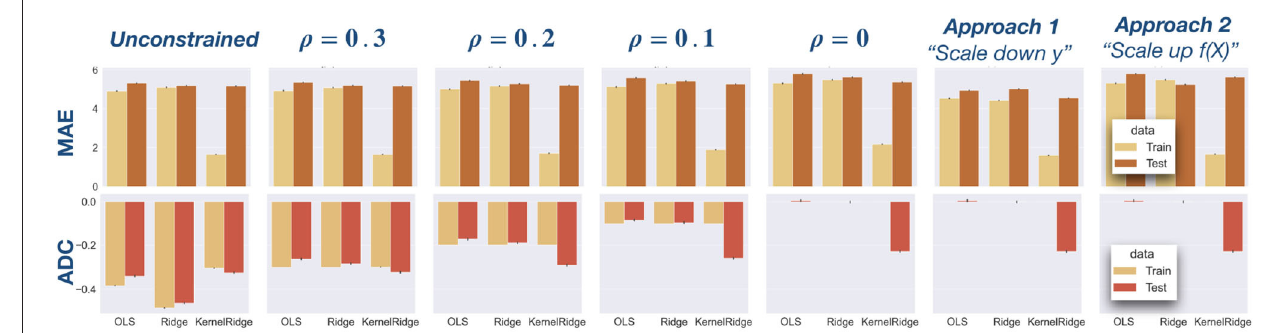
FIGURE 3 | Analysis of PAC data using OLS, Ridge, and Kernel Ridge regression models. In Table 2 , this data is show in tabular form. First row: Mean absolute error (MAE) is depicted for the three regression models and different constraints: unconstrained (standard regression model), bounded correlation ( ρ = 0.1,0.2,0.3), zero correlation ( ρ = 0), and approaches 1 and 2 from the literature (see Section 2.3). In terms of MAE, the best model on both train and test sets is Kernel Ridge regression. Second row: Age delta correlation (ADC) for different models and correlation constraints. Our models exactly control ADC on the training data and also reduce ADC on test